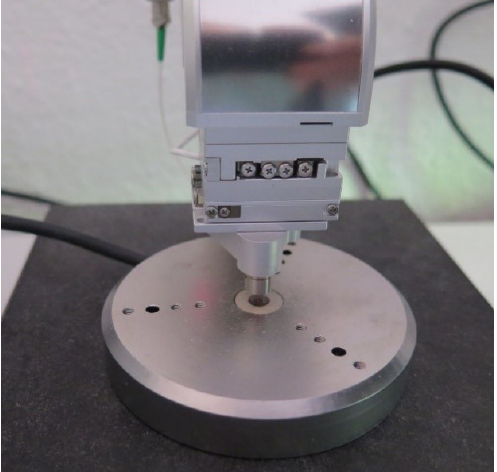
Figure 5. Measurement setup: the vibrometer head from the PicoScale vibrometer is raster-scanned over the sample, fixated onto the shaker stage for the dynamic characterization of the MEMS vibrom- eter chip.